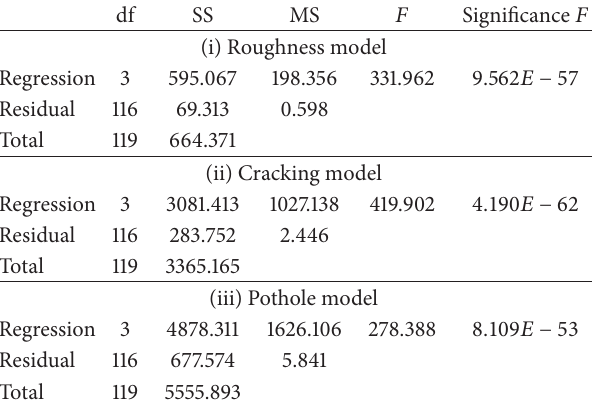
Table 5: ANOVA results of the